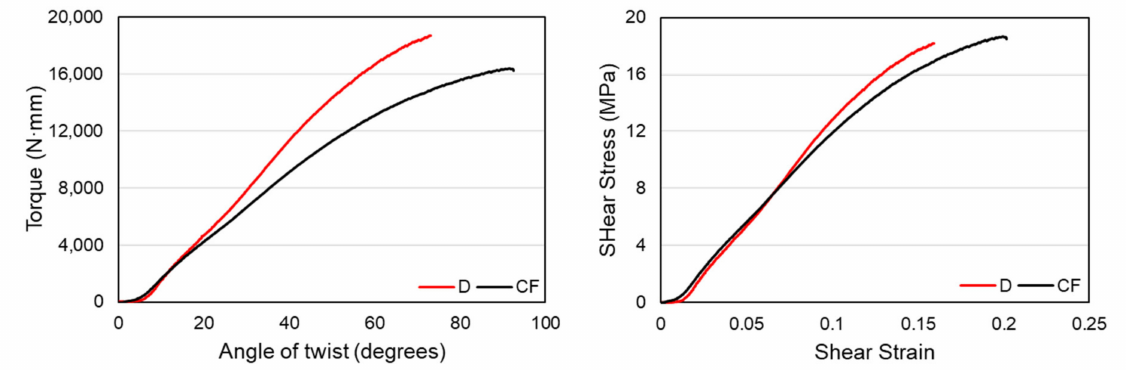
Figure 14. Comparison of torque-twist and shear stress-strain curves between D and CF